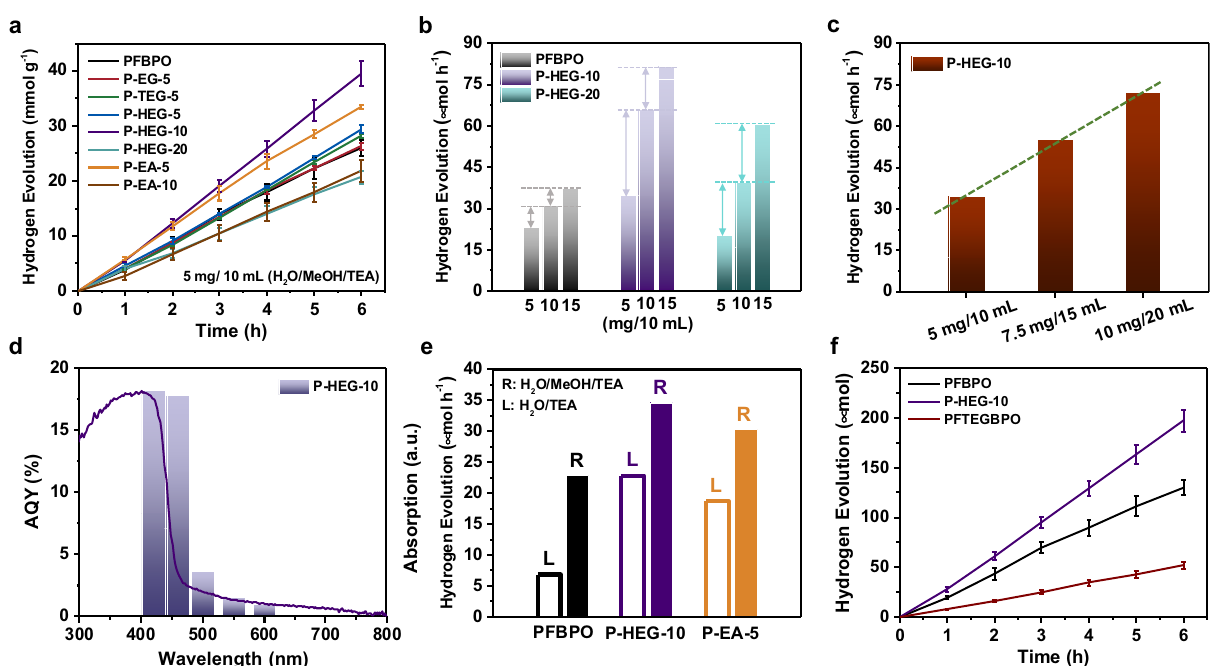
Fig. 4 | Photocatalytic hydrogen evolution experiments in solution. a Time- dependent HER of DCP and PFBPO photocatalysts under 380 – 780nm irradiation (5mg of polymer powder and 10mL of a mixed solution consisting of 33.3 vol.% H 2 O, 33.3 vol.% MeOH, and 33.3 vol.% TEA). b Concentration dependence of the HER over PFBPO, P-HEG-10, and P-HEG-20. c Linear relationship between the HER and the quantity of photocatalytic solution (10, 15, and 20mL of solution with a constant P-HEG-10 concentration). d Correlation between the apparent quantum